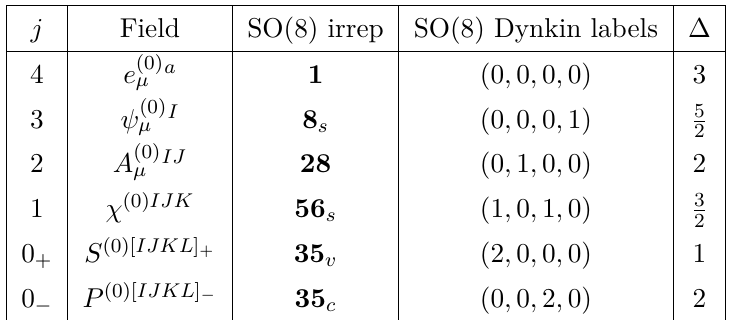
Table 1 . The massless N = 8 supermultiplet B 1 [0] (2 , 0 , 0 , 0)